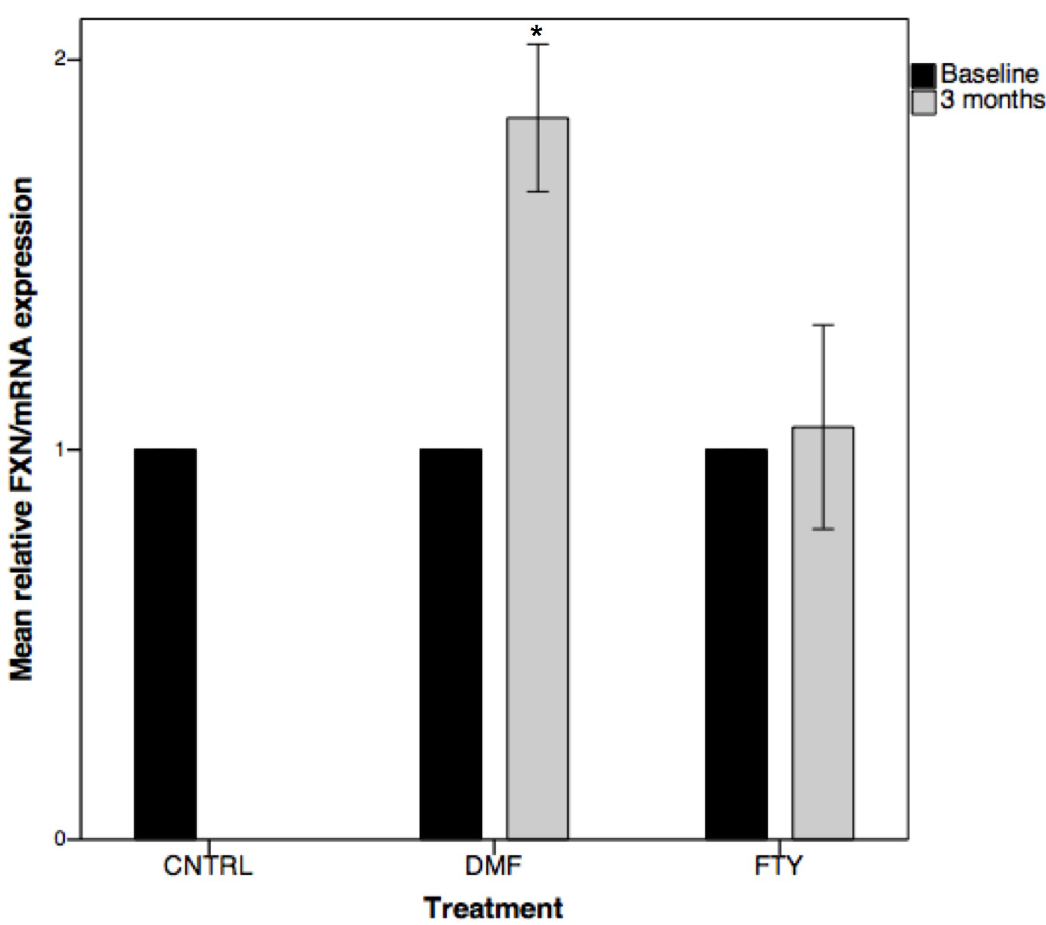
Fig 2. DMF increases FXN expression in peripheral blood mononuclear cells (PBMC’s) when dosed at 480mg/day in vivo in humans. 27 MS patients were recruited and 14 were treated with DMF and 13 with FTY for 3 months. Blood was drawn post treatment, PBMCs were isolated and FXN mRNA expression was measured pre and post treatment by qRT-PCR. Baseline values of FXN/mRNA expression were set at 1 and 3 months values are shown relative to baseline values. CNTRL = Controls (n = 12); DMF = Dimethylfumarate (n = 14); FTY = Fingolimod (n = 13);. Bars represent median ± error standard mean (p < 0.05 � ).